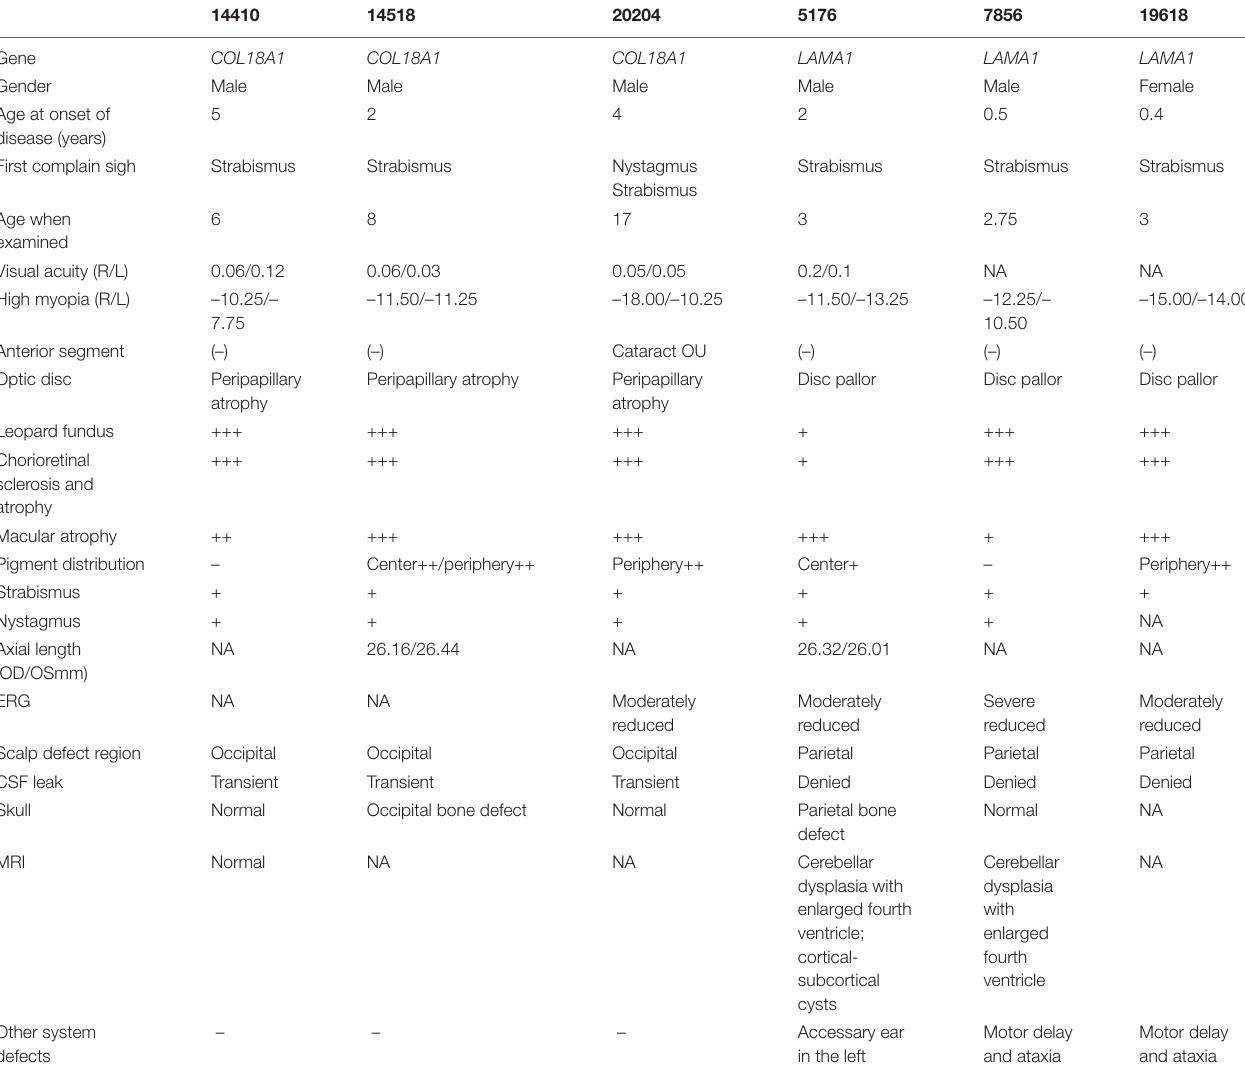
TABLE 1 | Summary of clinical data in high myopia patients with alopecia areata in the cranial